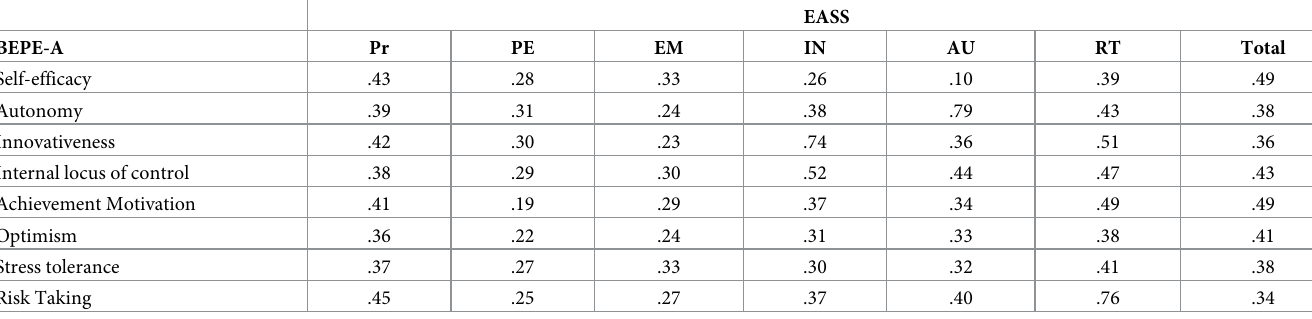
Table 5. Pearson’s correlations between the BEPE-A dimensions and total score and the EASS subscales.